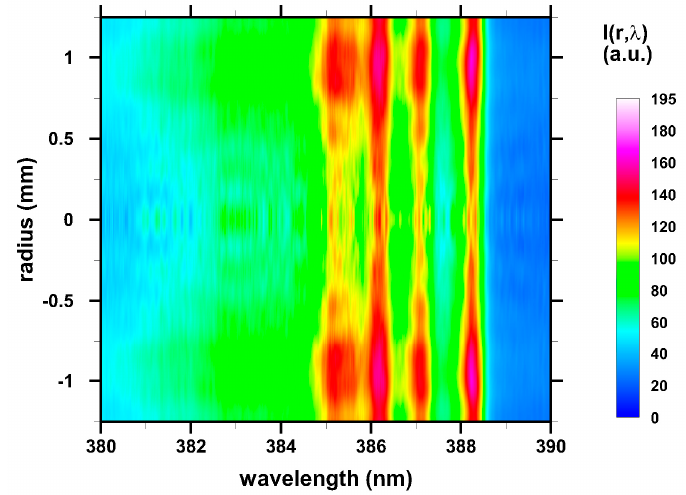
Figure 6. Abel-inverted spectra versus radius at 1.2-µs time delay, gate 0.125 µs [16].